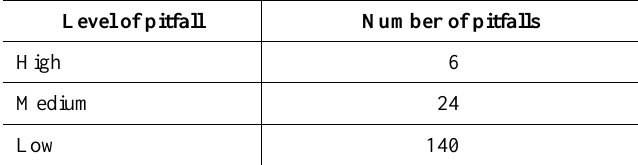
Table 6: Pitfalls per